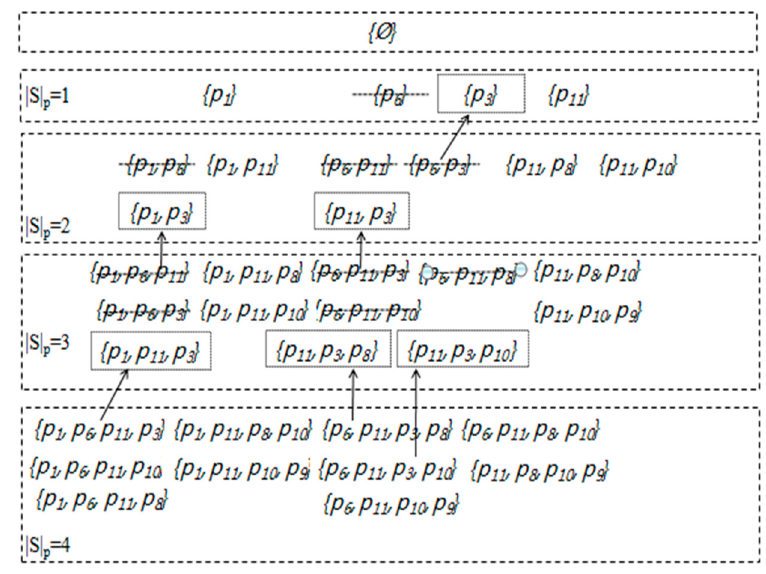
Figure 11. Finding G-Skyline when point p 6 expires.